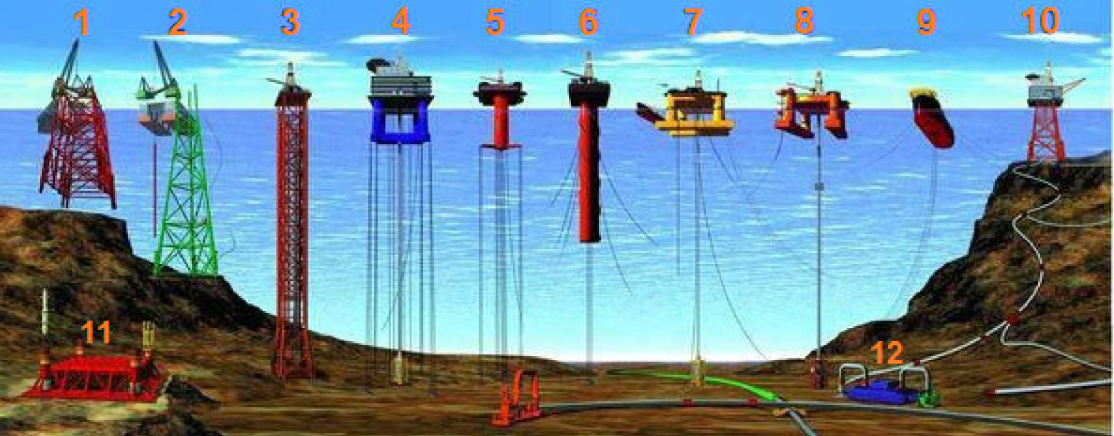
Figure 1. Different types of deep-water offshore production facilities, showing (1,2) conventional fixed platforms{150–412 m}; (3) compliant tower {457–914 m}; (4,5) tension leg platform (TLP) {457–2134 m}; (5) mini tension leg platform (TLP); (6) Truss SPAR {610–3048 m}; (7,8) semisubmersibles {457–1920 m}; (9) floating production, storage and offloading (FPSO) unit {1345–1500 m}; and (10) jacket platform {150–412 m}; and (11) subsea completion and tieback to a host facility, and (12) subsea manifold. (Adapted from public domain source, with permission obtained to re-use image; Courtesy: National Oceanic and Atmospheric Administration,